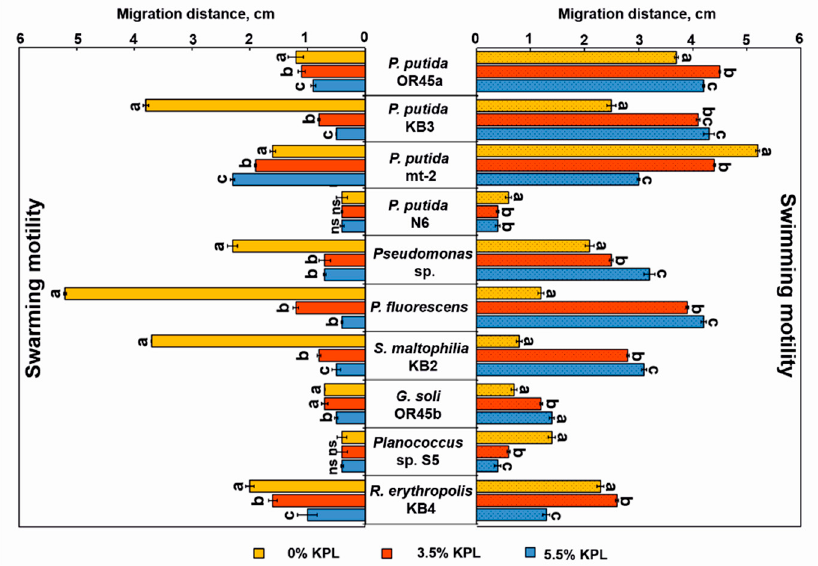
Figure 5. Motility behavior of the tested strains in response to the KPL.